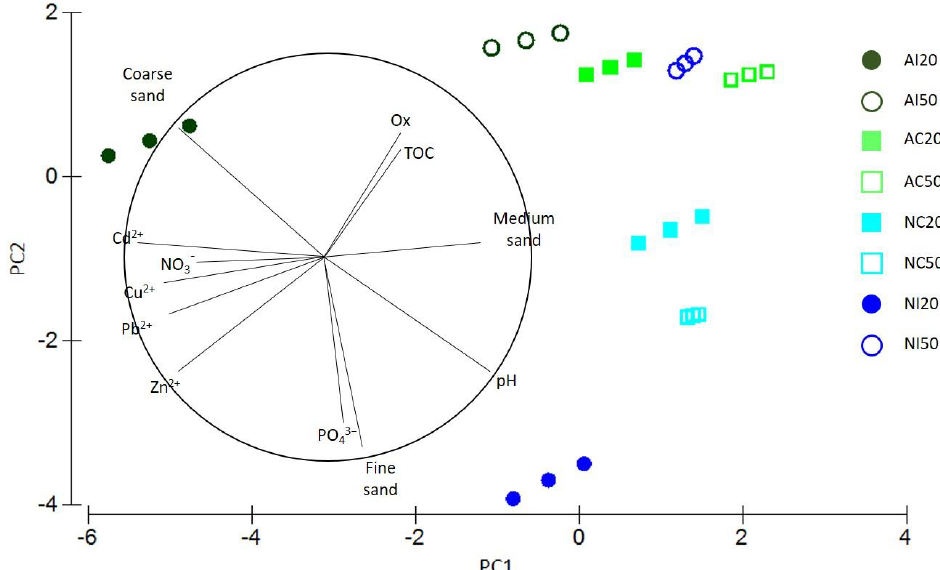
Figure 4. Ordination plot on environmental data and coming from PCA analysis. Replicates of Ar × De interaction are here shown. Strength lines are vectors that graphically show the correlation of physical and chemical correlation with different clusters.